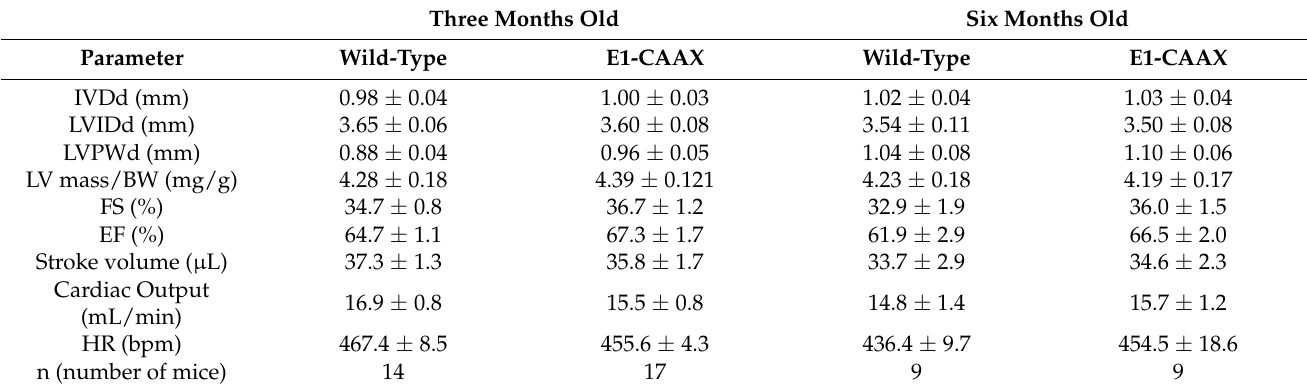
Table 1. Echocardiographic parameters of Epac1-CAAX mice compared to wild-type littermates. Three Months Old